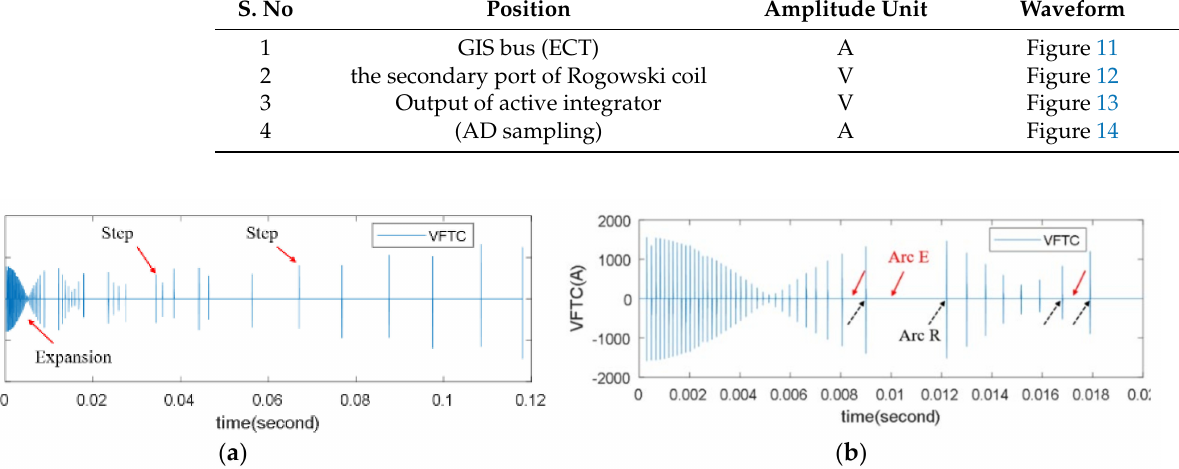
Figure 11. VFTC waveforms at GIS bus (ECT) and its expansion (S. No1): ( a ) VFTC waveforms; ( b ) the expansion of VFTC waveforms.